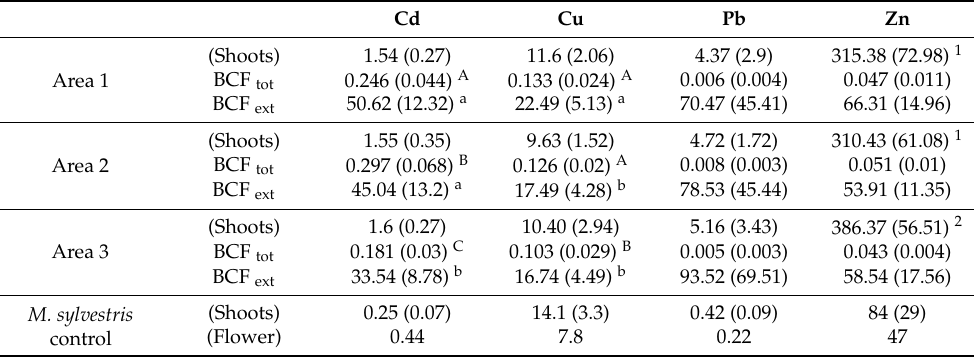
Table 4. TE concentration in the aerial part (shoots and flower, µ g g − 1 DW) and bioconcentration factor (BCF) of M. sylvestris L. cultivated in the three areas and TE concentration in the aerial part and flower of M. sylvestris L. cultivated in the uncontaminated site (control). With the exception of the M. sylvestris control flower ( n = 1), the results are reported as means ± standard deviations (SD) ( n = 10 for shoots from the 3 areas and corresponding BCF; n = 3 for shoots of M. sylvestris control). Significant differences between areas are indicated by different letters or numbers at the level of α = 0.05 (lowercase for BCF tot; uppercase for BCF ext, number for shoots). Cd Cu Pb Zn Area 1